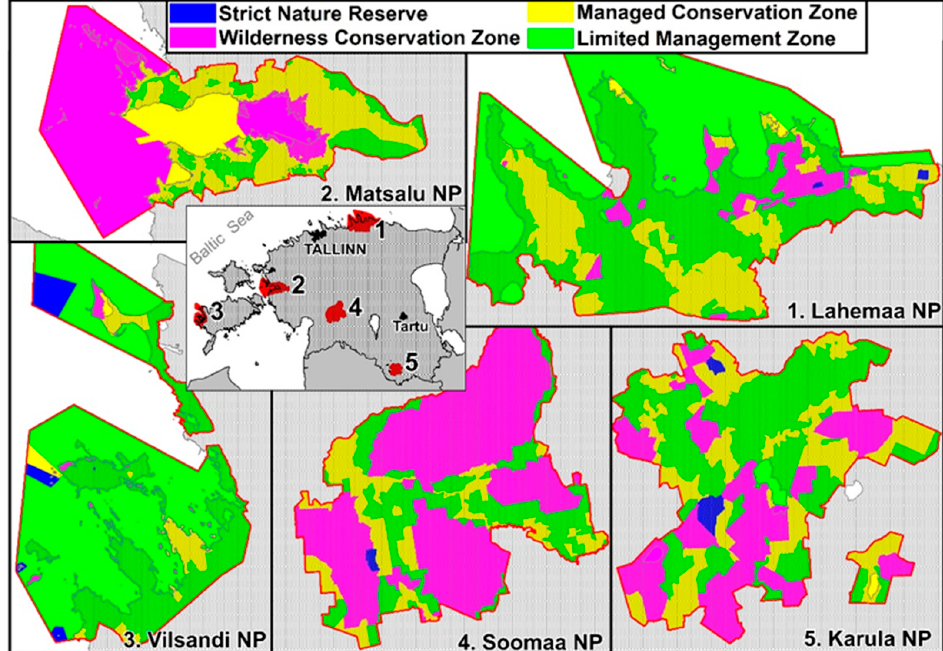
Figure 2. Locations and zoning of the study areas.